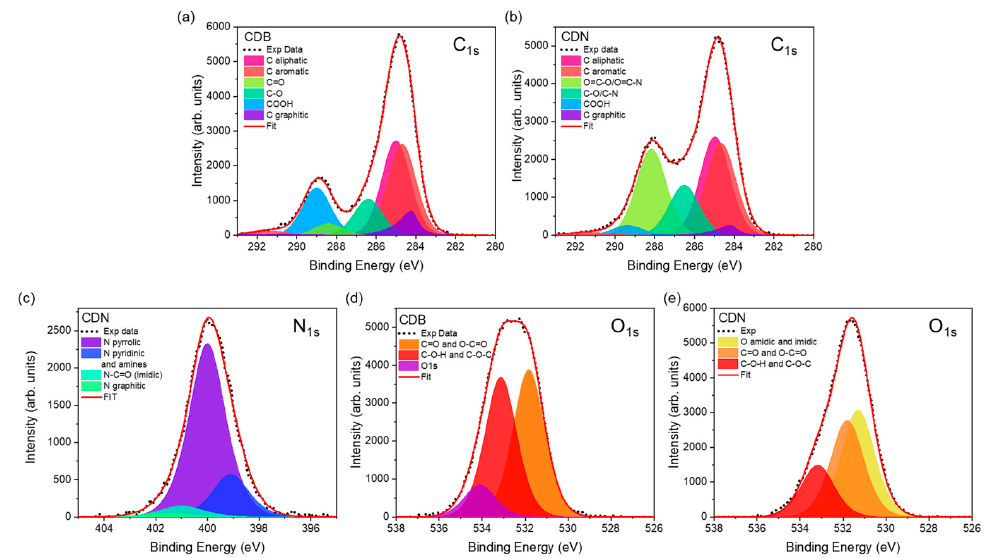
Figure 3. ( a , b ) C 1s and ( c – e ) N 1s and O 1s XPS spectra of CDB and CDN samples. The excitation/emission maps (EEM) of the CDB and CDN samples are reported in Figure 4, along with their QY values at a 350 nm excitation wavelength which result to be 1.1% and 4.7% for the CDB and CDN, respectively. The maps show, in both cases, the presence of two emitting centers, one in the blue and the other in the green spectral range. In the CDB, the blue contribution that peaked at 445 nm can be excited both in the far- (245 nm) and in the near-UV (345 nm) region whilst under the blue excitation wavelength (440 nm) a green luminescence (520 nm) is observed. Similar findings are reported for the CDN sample where the blue band that peaked at about 430 nm is mainly excited by UV excitation at 350 nm with an excitation shoulder at 250 nm. The green band is centered at about 520 nm and is mainly excited at 430 nm, with another smaller excitation band in the same UV range as the blue one. Finally, we observe that the relative content of the green band as compared to the blue one is larger in the CDN samples.